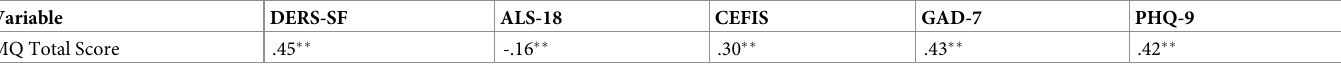
Table 2. Bivariate correlations between measures of misophonia, difficulties with emotion regulation, affective lability, COVID-19 impact, anxiety, and depression. Variable